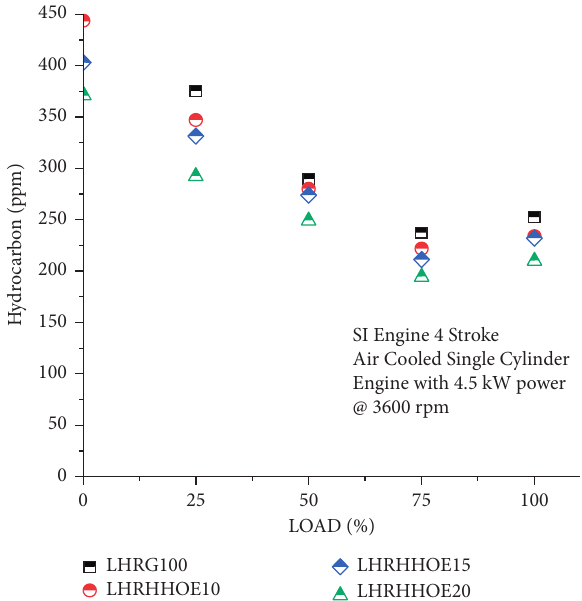
Figure 5: Study on hydrocarbon emission on nanocoated ethanol- gasoline